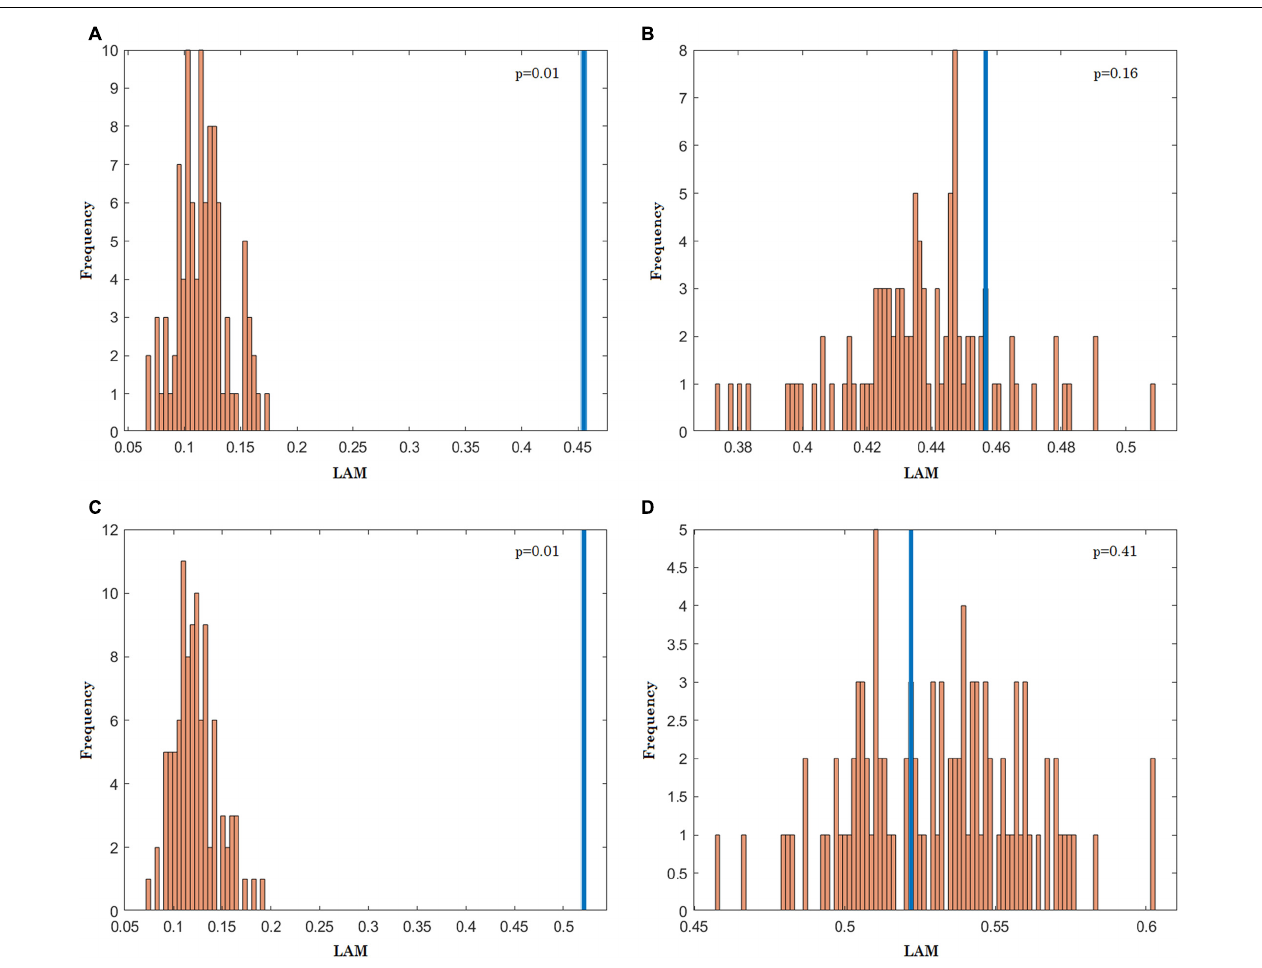
FIGURE 4 | Histograms for the laminarity (LAM) values of recurrence plot from of 99 surrogates (orange) obtained with Iterative Amplitude Adjusted Fourier Transform (IAAFT) and Pinned Wavelet Iterative Amplitude Adjusted Fourier Transform (PWIAAFT) techniques. The LAM values measured from the original data are depicted in blue. AR2s, IAAFT (A) , PWIAAFT (B) ; AR2ns, IAAFT (C) , PWIAAFT (D)